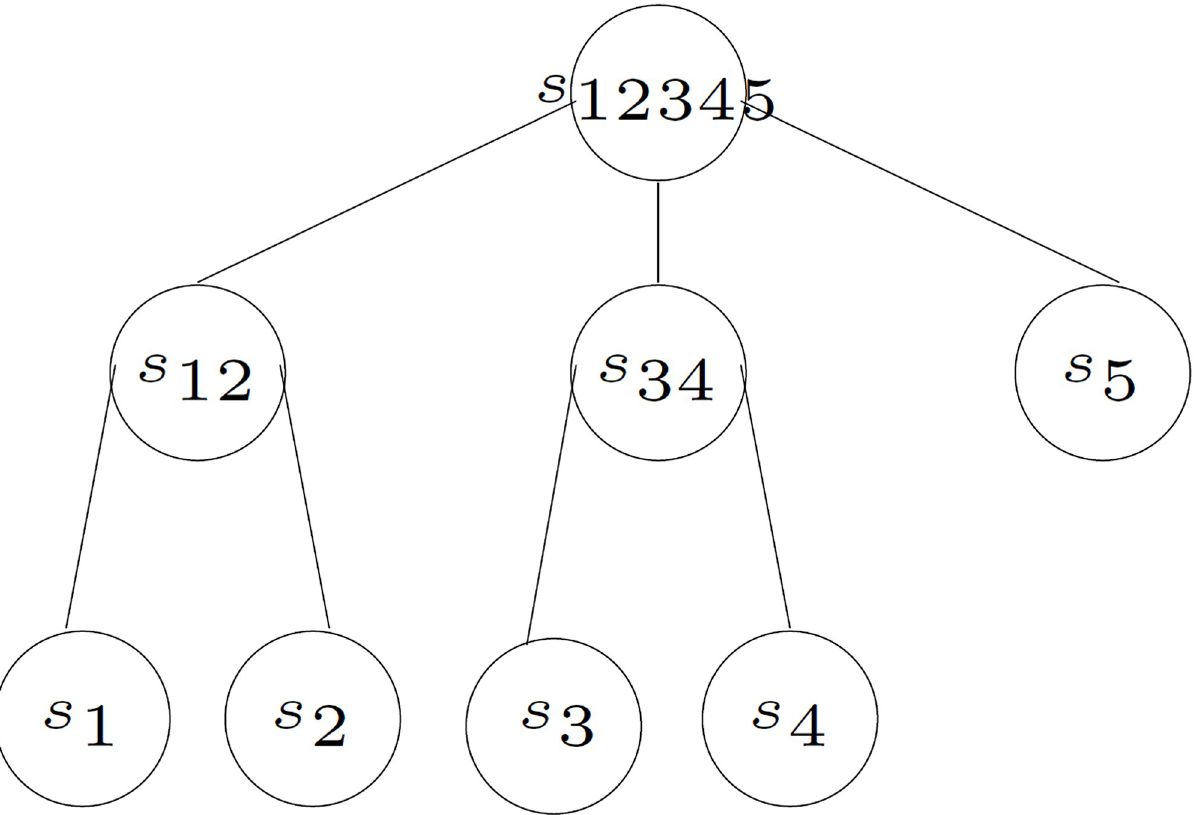
Fig 16. The tree corresponding to the set of posets P in Fig 15.